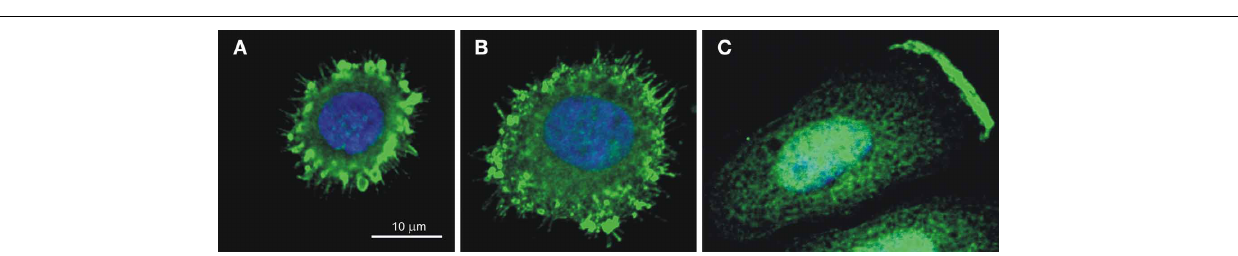
FIGURE 5 | CA IX localization in the spreading cells (A,B) and in the lamellipodium of the migrating cell (C). Immunofluorescence staining of hypoxic SiHa cells attaching to the collagen support shows that CA IX is recruited (A) to filopodia and to emerging focal contacts in the early stage of spreading (10min after seeding) and (B) to maturing focal adhesions in the later stage (20min after seeding). SiHa cells incubated in hypoxia for 48h and